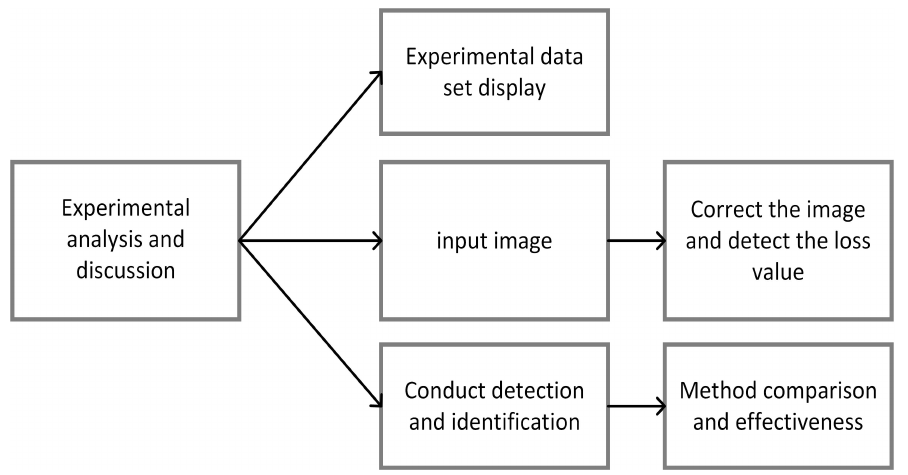
Figure 7. Overall flow chart of the experiment.